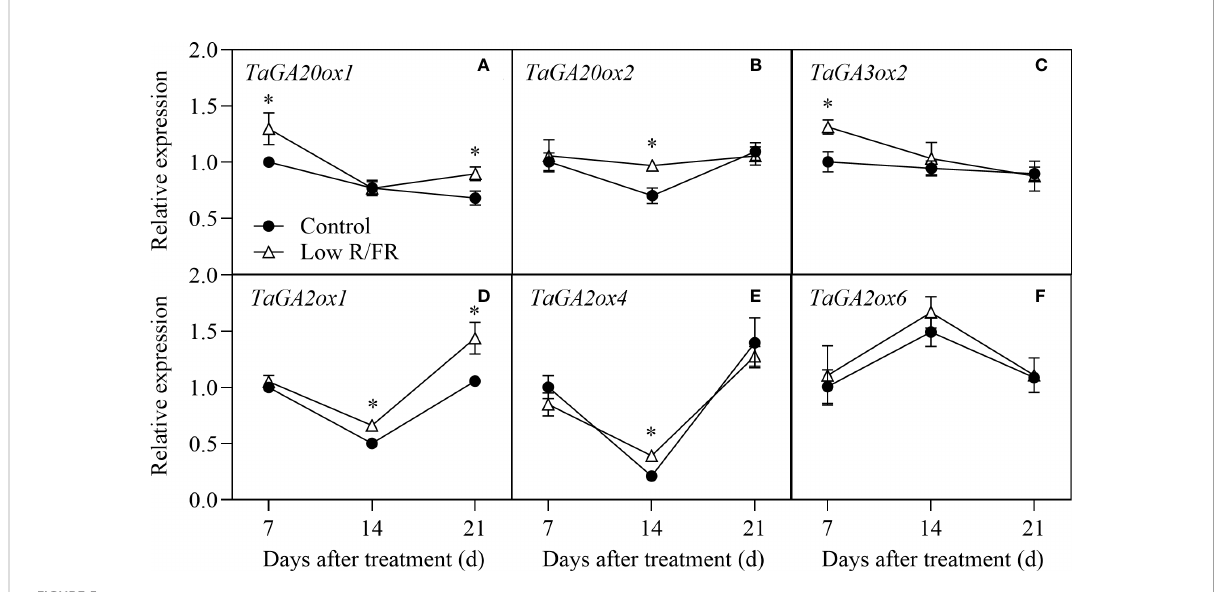
FIGURE 5 Expression of GA metabolism genes in tiller nodes under control and low R/FR conditions. Relative transcript levels of TaGA20ox1 (A) , TaGA20ox2 (B) , TaGA3ox2 (C) , TaGA0ox1 (D) , TaGA2ox4 (E) , and TaGA2ox6 (F) in tiller nodes treated for 7, 14 and 21 d. Data are the means of three biological replicates ± SE, and the asterisk denotes a statistically remarkable difference ( P < 0.05) between treated and control